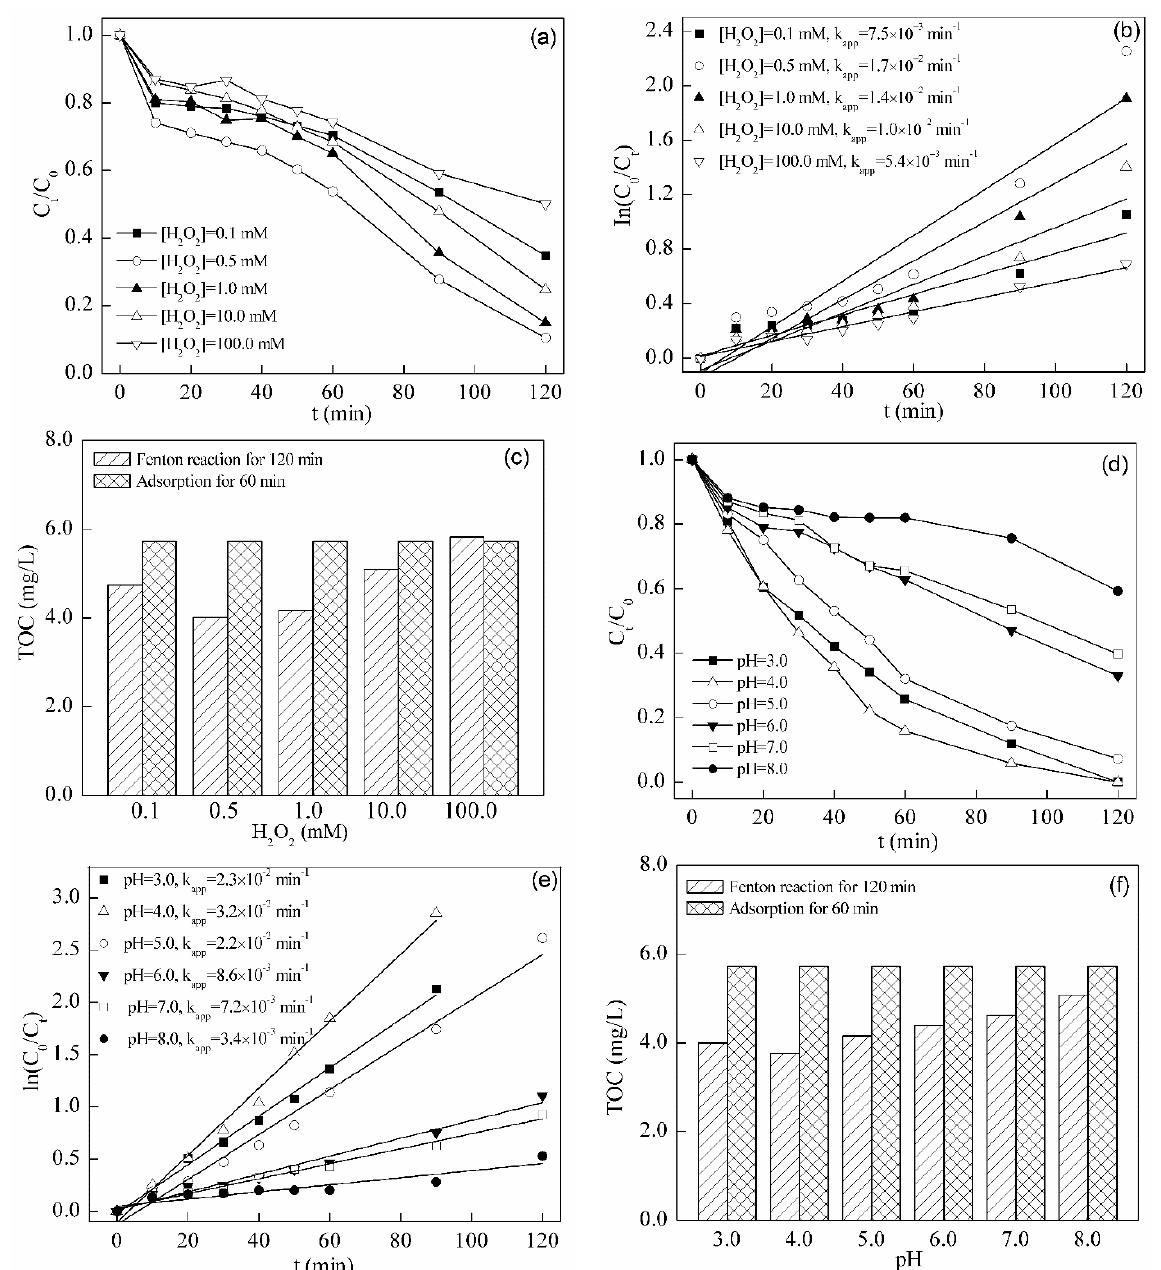
Figure 5. Cont Figure 5. Cont.